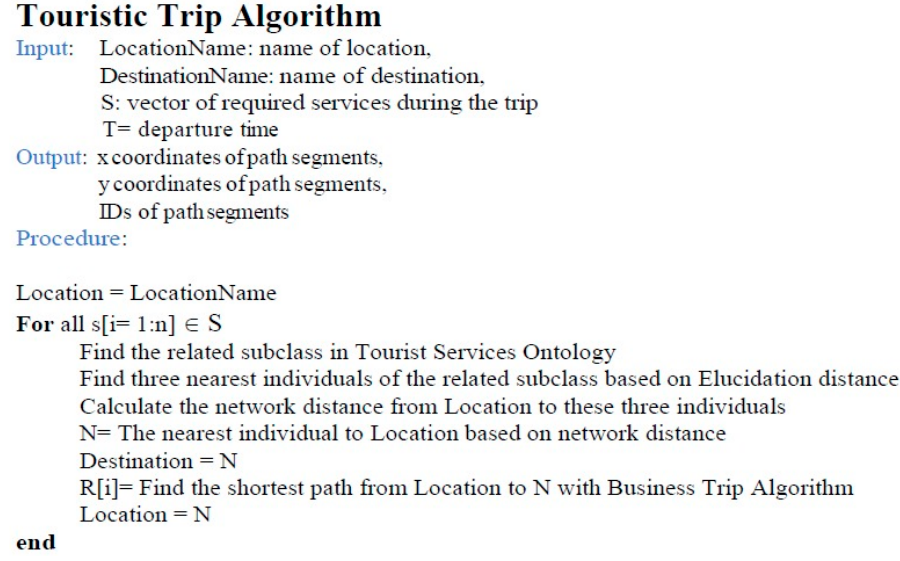
Figure 7. Touristic trip algorithm.